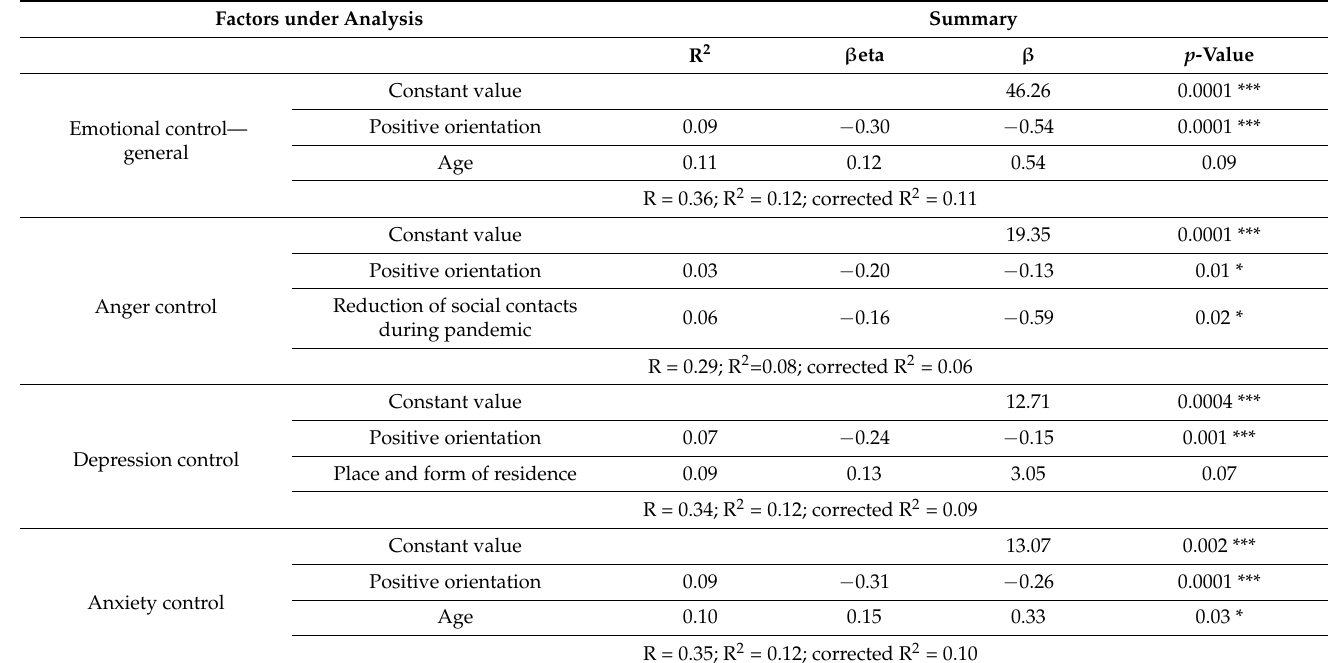
Table 5. Multiple regression results—predictors of emotional control—general, concerning anger, depression and anxiety in the Spanish study.